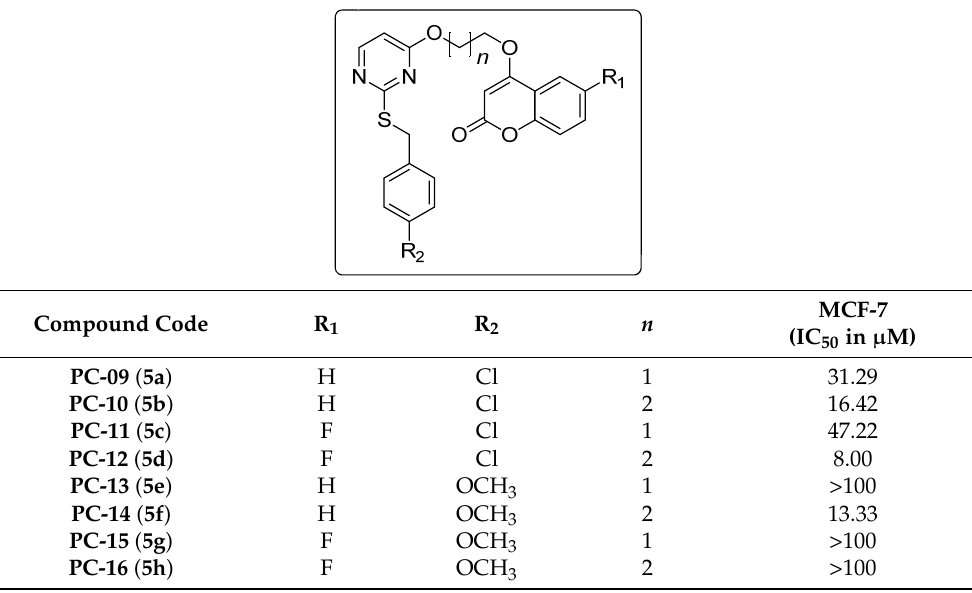
Table 1. Structural, physical, and cell viability data of compounds ( 5a – h ).